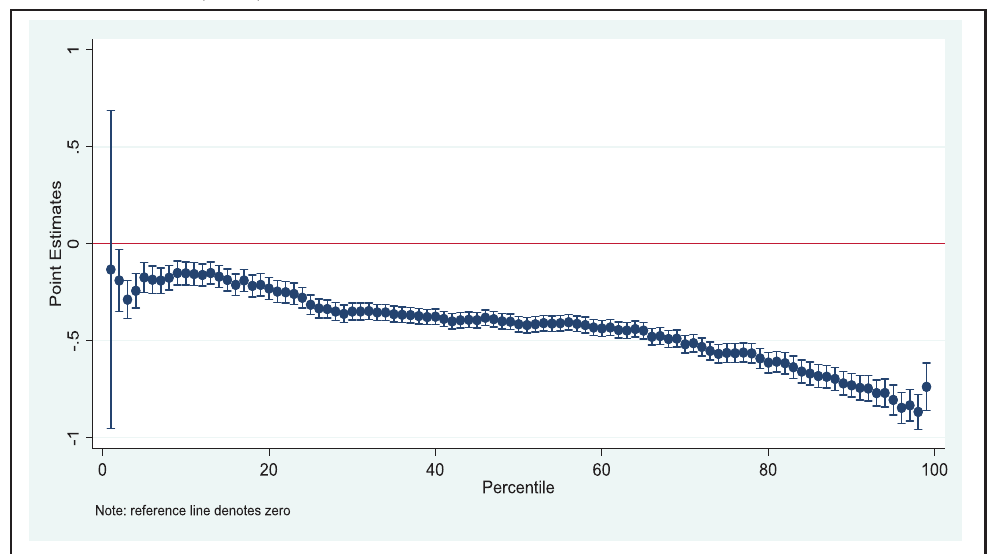
Figure 5 Point Estimates and 95% Confidence Intervals for Quantile Conflict Treatment Effects